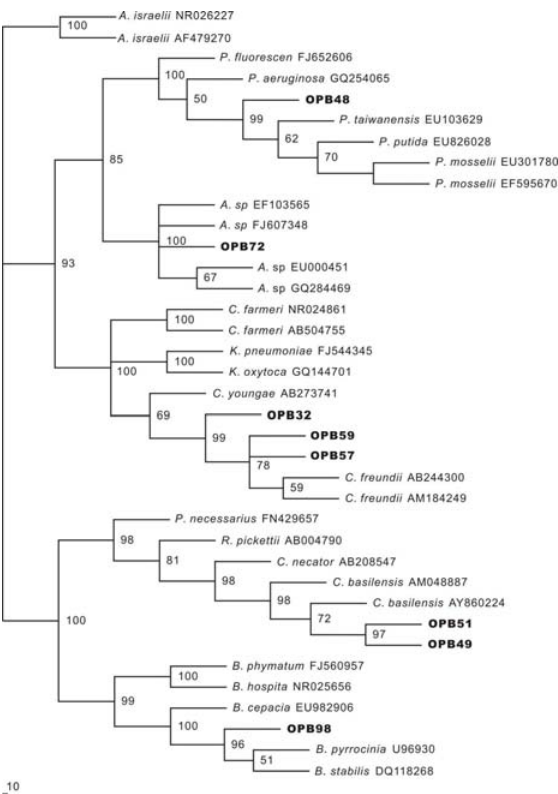
Figure 2. Phylogenetic analysis of OPB and IPB based on partial 16S rDNA sequence and those stored in public nucleotide databases. The tree was constructed by using Paup v.4.0b.8.a Software. Distance matrix was calculated by Kimuras two-parameter model. Bootstrap values based on 1,000 replications are listed as percentages at the branching